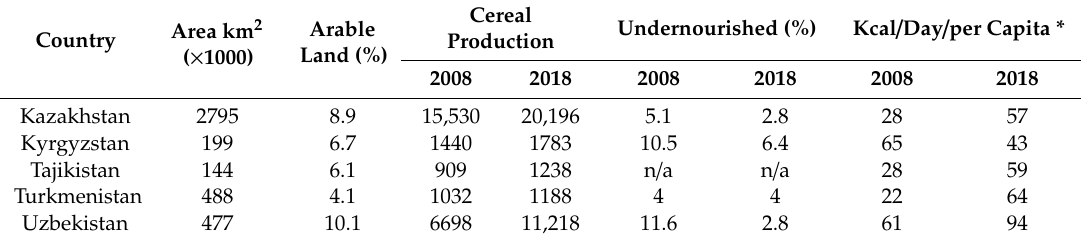
Table 3. Food production and vulnerability in Central Asia [23–25].